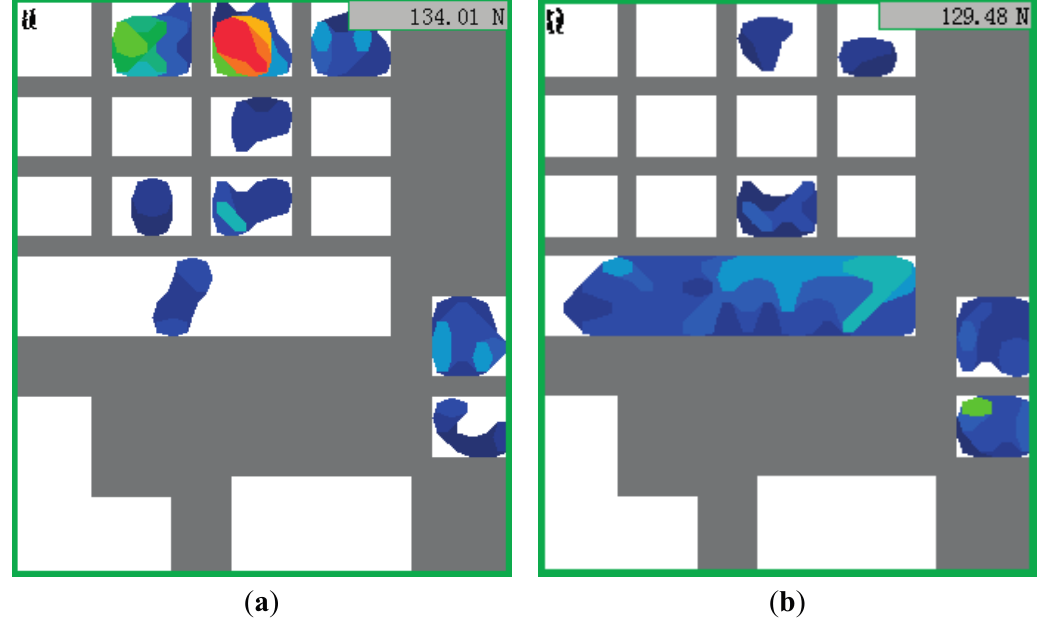
Figure 10. ( a ) Grip force distribution of acceleration; ( b ) Grip force distribution of